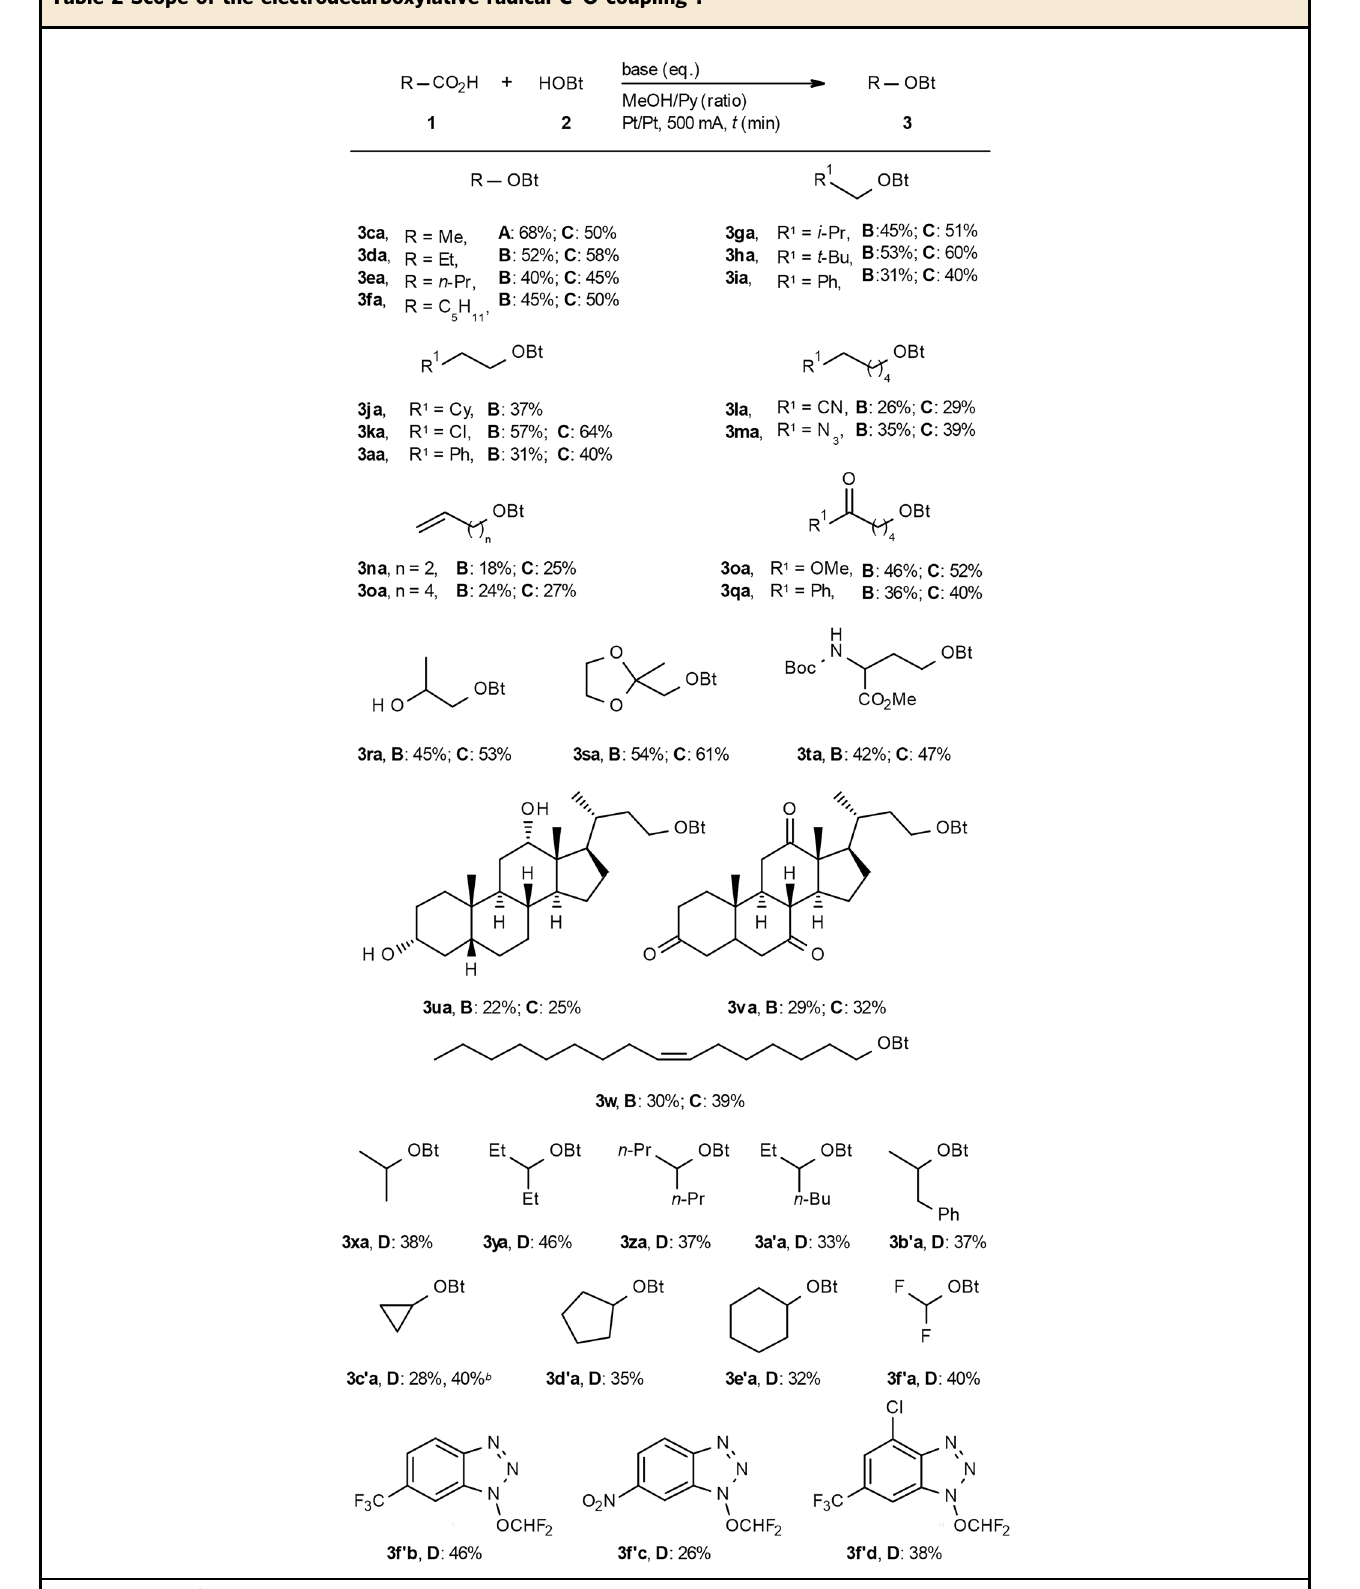
Table 2 Scope of the electrodecarboxylative radical C – O coupling a